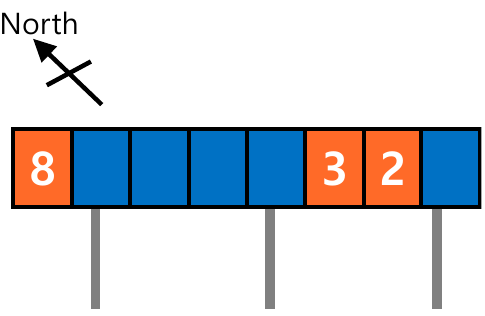
Figure 7. Layout of the modules measured for temperature for Testbed 3: neighboring modules (modules no. 2 and no. 3) and distant modules (modules no. 2 and no. 8).